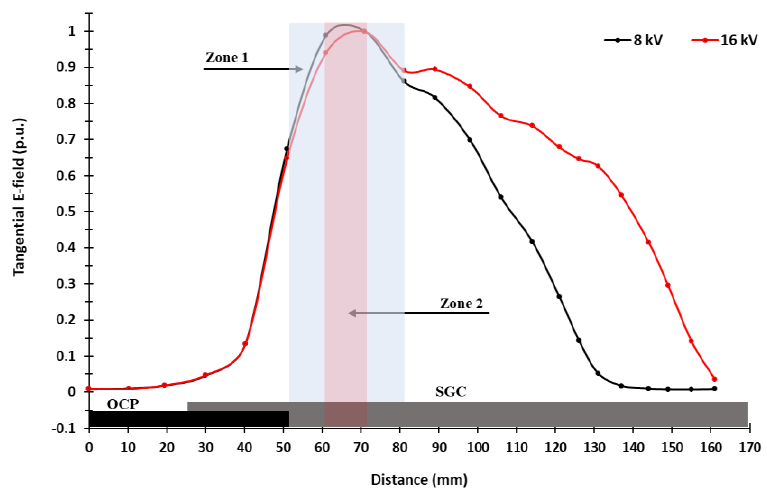
Figure 8. Comparison of the normalized E t distributions (in p.u.) obtained at the surface of the stress grading system for an applied voltage of 8 kV rms and 16 kV rms .